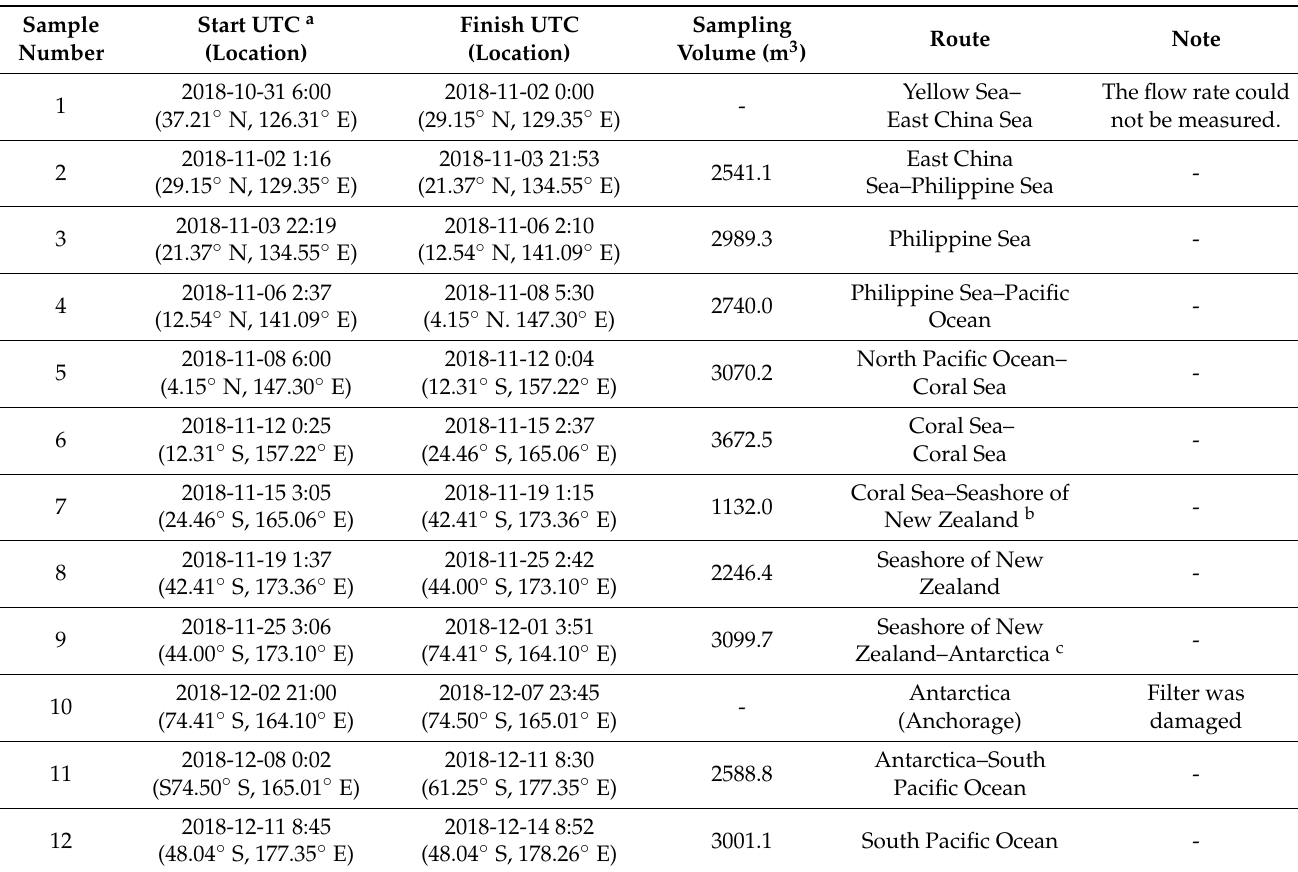
Table 3. Sampling information, including sampling time, location, volume, and